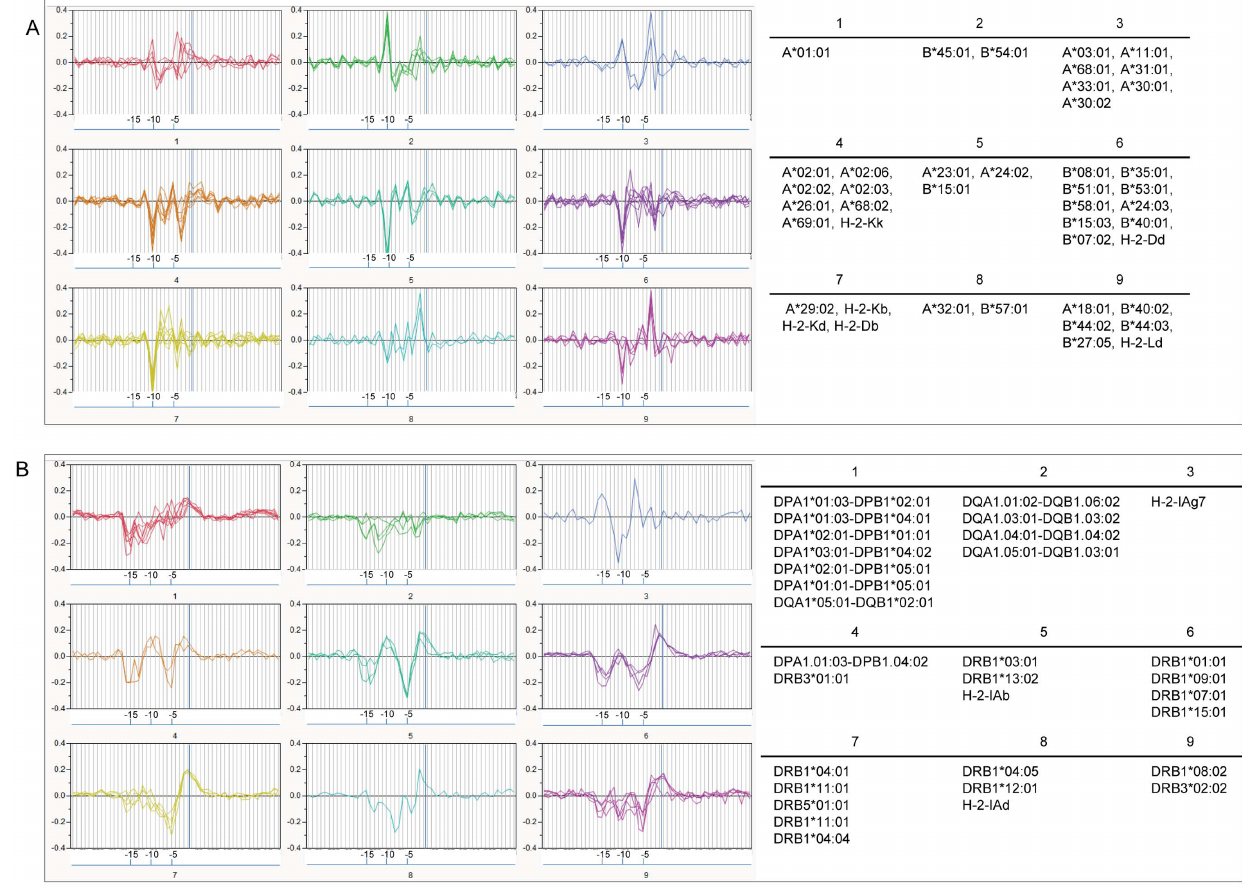
Figure 3. Parallel plots of cross correlation of predicted MHC binding with cathepsin L cleavage for clusters of alleles in tetanus toxin. The cross-correlation hierarchies of Figure 2 are shown separated by allele clusters to differentiate their patterns. The blue vertical line marks the P1P1’ cathepsin scissile bond position. The numbering of the X axis reflects amino acid positions proximal of the human cathepsin L cleavage site. The 95 percentile confidence limits differ for each panel, but range from 6 0.02–0.05 and are not shown for clarity. Thus the prominent peaks in the graphs are statistically significant but the smaller oscillations of the graphics around zero are not. The corresponding plot for all 11 proteins is shown in Figure S3.2.